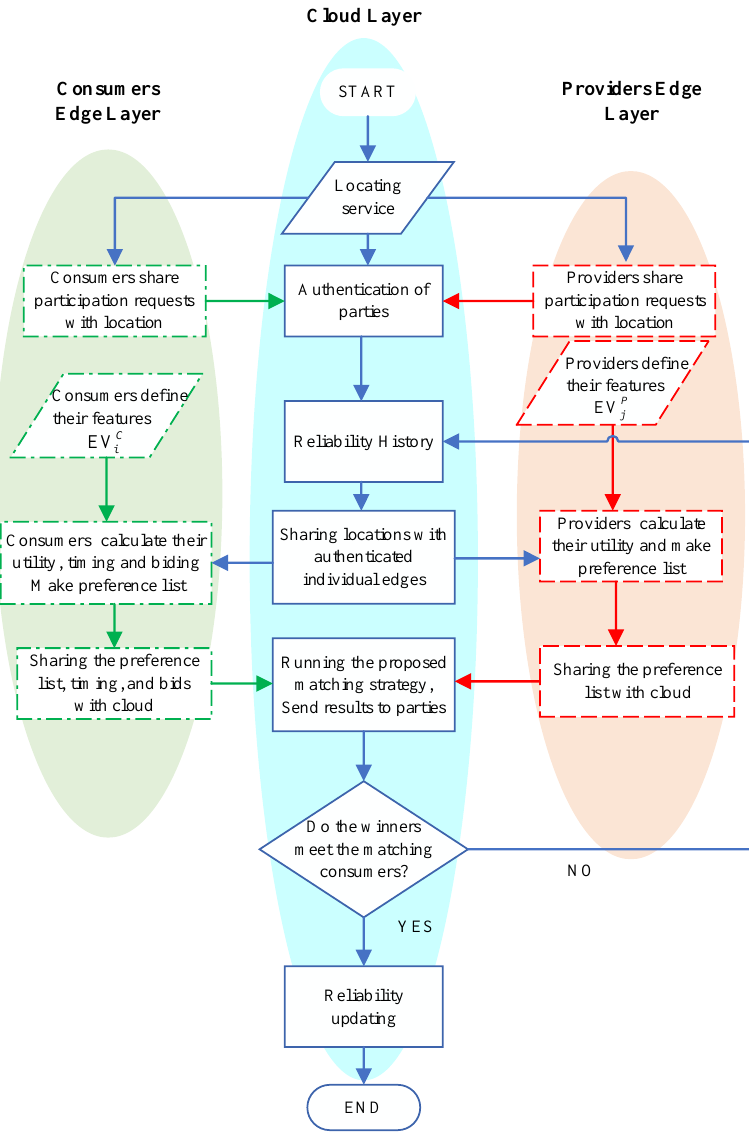
Figure 3. A flowchart of the proposed cloud-edge emergency energy trading framework.